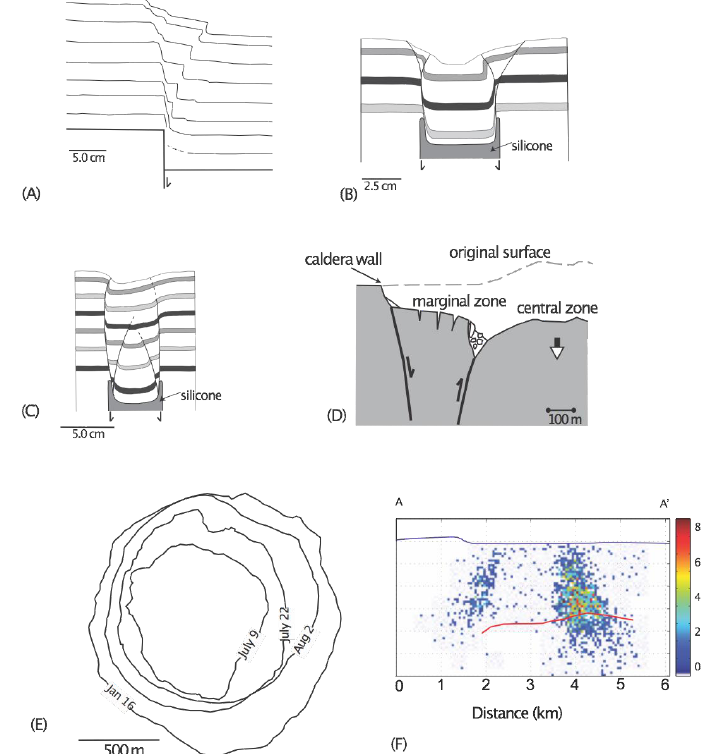
Figure 1. ( A–C ) Examples of experimental, 2D sandbox analogue models: ( A ) Line drawing of simple piston-like subsidence beneath a sand cover, redrawn from Horsfield [25]; ( B,C ) Piston-like withdrawal of a silicone reservoir underlying a sand cover, redrawn from Merle et al. [2]; ( D ) Schematic illustration of the structure of the Miyakejima caldera, Japan in the early stages of subsidence (9 July 2000), where an (early) inner reverse fault borders the central zone and a later, outer, normal fault limits the marginal zone (redrawn from Geshi et al. [3]); ( E ) Surface expression (caldera rim) of the Miyakejima caldera, Japan from the early stages of subsidence (9 July 2000) to post eruption (16 January 2001) (redrawn from Geshi et al. [3]); ( F ) Seismicity during the 2015 eruption of Axial Seamount (o ff shore Oregon, USA) showing earthquake density on a cross section, where the red line delineates the top of the magma chamber (redrawn from Levy et al.